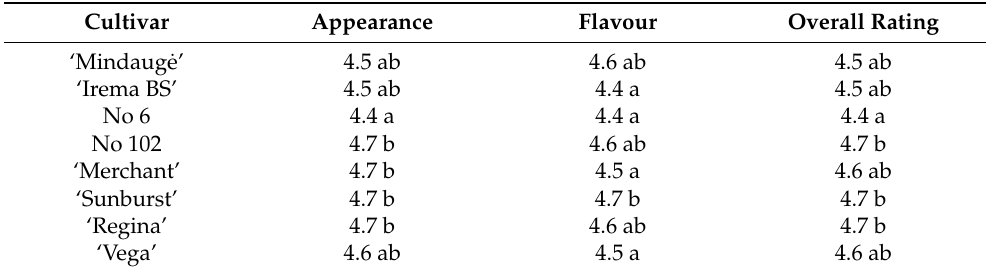
Table 7. Sensory evaluation of sweet cherry fruits (1–5 score scale), and average data of 2018 and 2020. Values marked with different letters are statistically different within the columns ( p ≤